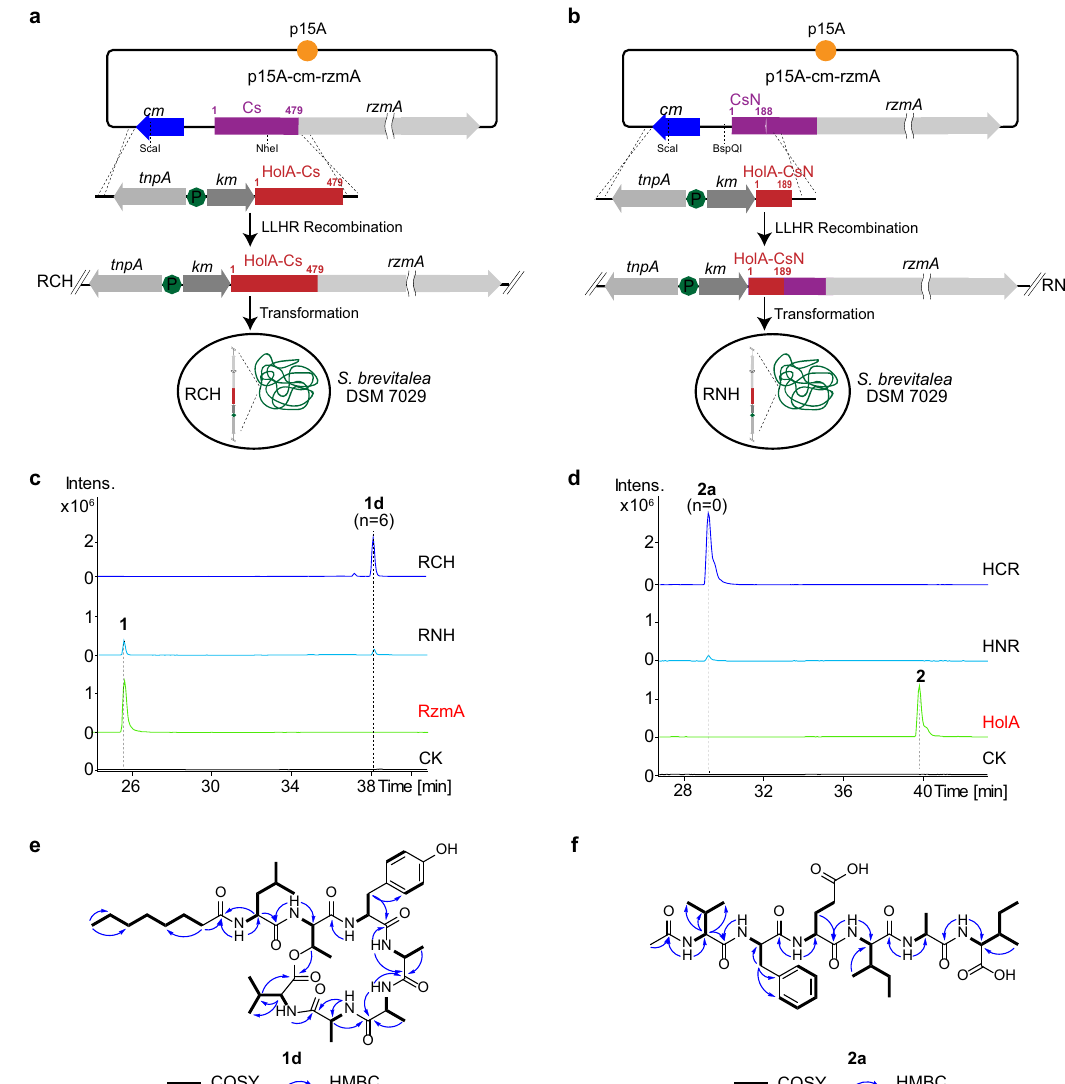
Fig. 2 Exchanging the acyl chains of nonribosomal lipopeptides by Cs (sub)domain swapping. a , b Swapping strategy for full-length Cs domain (RCH, a ) and N-terminal Cs domain (RNH, b ) of RzmA with those of HolA using recombineering in E. coli 46 . The resulting constructs (RCH and RNH) were transformed into S. brevitalea DSM 7029 for heterologous expression. The Cs (sub)domain swapping of HolA with those of RzmA (HCR and HNR) was conducted in the same way. c , d Comparative production analysis of full-length and N-terminal Cs domain swapping of RzmA ( c ) and HolA ( d ) showed an exchange of the acyl chains with different ef fi ciencies. Extracted ion chromatograms (EICs) at m / z = 732.391 ([M + H] + , 1 ) and 816.483 ([M + H] + , 1d ) for ( c ), and at m / z = 817.503 ([M + H] + , 2 ) and 733.412 ([M + H] + , 2a ) for ( d ). CK represents the wild type of S. brevitalea DSM 7029. e , f Structures and key COSY and HMBC correlations of 1d and 2a . tnpA transposase gene, km kanamycin resistance gene, cm chloramphenicol resistance gene, P